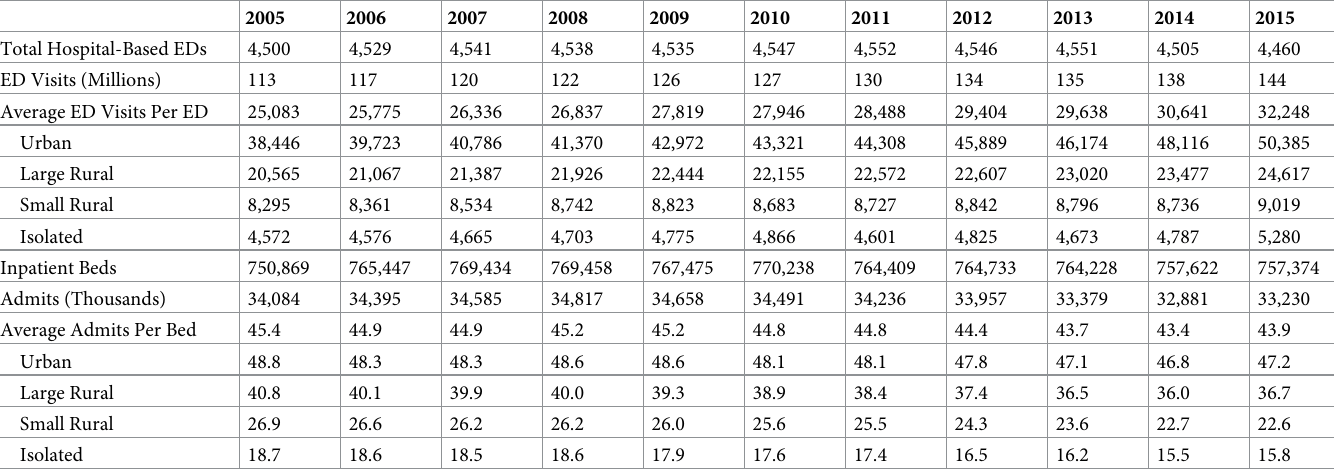
Table 3. Nationwide ED and inpatient utilization, 2005–2015.